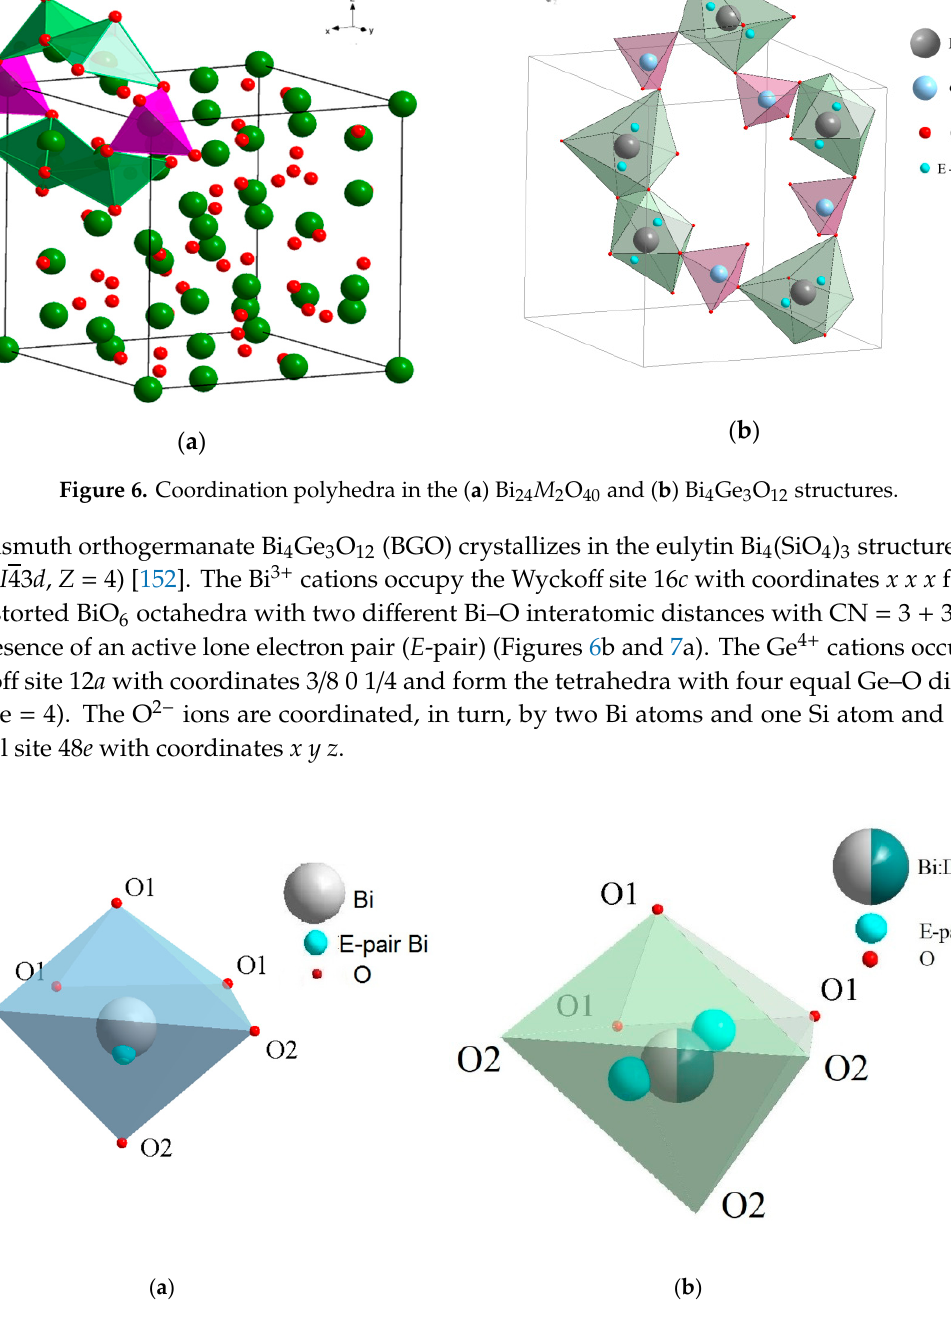
Figure 7. ( a ) BiO 6 polyhedron with a lone electron pair in the Bi 4 Ge 3 O 12 structure; ( b ) The (Bi,Dy)O 6 polyhedron in the BGO:Dy structure. Oxygen atoms distributed over one right system of points in the BGO structure are conventionally marked as O1 and O2.